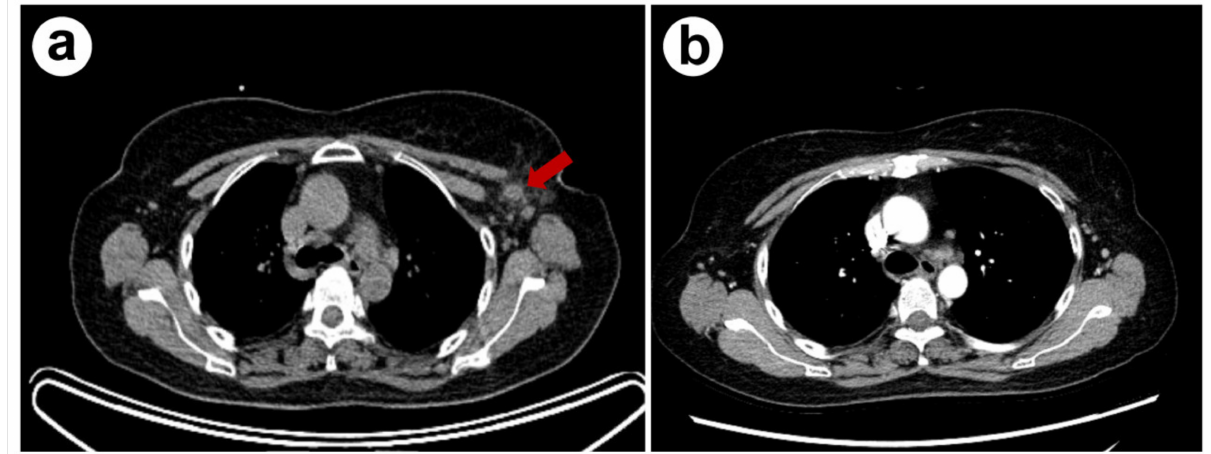
Figure 4. ( a ) Enlarged lymph nodes on the axillary area (red arrow) were observed detected during 18 F-FDG PET/CT scan. ( b ) Contrast-enhanced chest CT performed one month after discharge, enlargement of axillary lymph node was